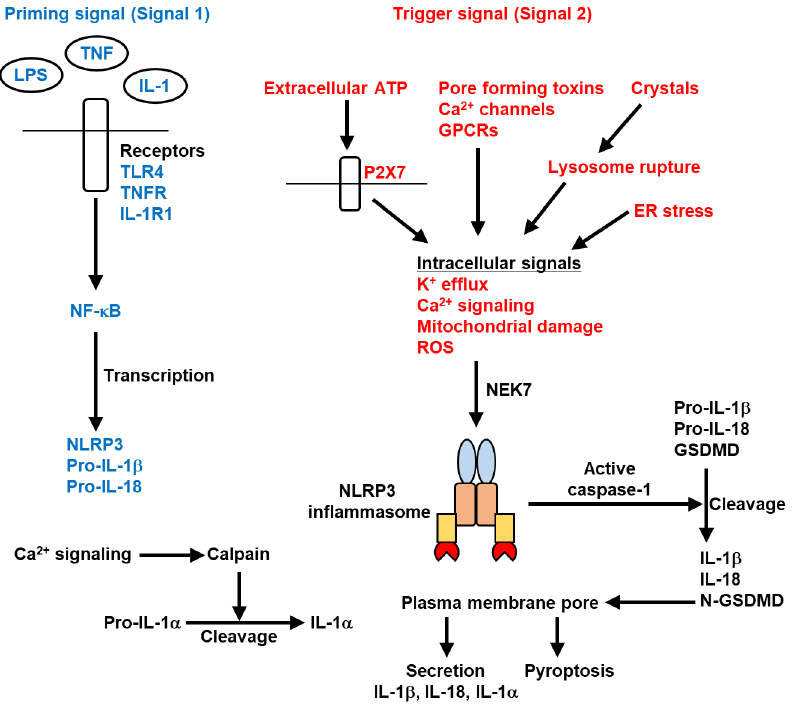
Figure 2. Mechanism of NLRP3 inflammasome activation. Pathogen-associated molecular patterns (PAMPs), such as lipopolysaccharide (LPS), or cytokines, such as TNF α and IL-1, induce a priming signal (Signal 1). The priming signal promotes expression of NLRP3, IL-1 β , and IL-18 through NF- κ B signaling. A trigger signal (Signal 2) is induced by specific PAMPs or damage-associated molecular patterns (DAMPs) such as bacterial infection, extracellular ATP, crystals, lysosomal rupture, mitochondrial damage, and endoplasmic reticulum (ER) stress, and leads to the assembly of NLRP3, ASC, and pro-caspase-1. Extracellular ATP stimulates P2X7 receptor. Phagocytosis of crystals induces lysosomal rupture. K + efflux, Ca 2+ signaling, mitochondrial damage, and reactive oxygen species (ROS) have been proposed to be the intracellular signals for NLRP3 inflammasome activation, while K + efflux is thought to be the most important signal. These intracellular signals are provided by at least the P2X7 receptor, pore-forming toxins, Ca 2+ channels, lysosomal rupture, ER stress, and G protein-coupled receptors (GPCRs). NEK7 is an essential positive regulator of the NLRP3 inflammasome and acts downstream of K + efflux. The NLRP3 inflammasome activates caspase-1, inducing IL-1β and IL-18 maturation and GSDMD cleavage. Pro-IL-1α is cleaved by Ca 2+ -dependent protease calpain and becomes mature IL-1α. N-terminal fragments of GSDMD (N-GSDMD) insert into the plasma membrane and form pores, leading to pyroptosis and secretion of IL-1β, IL-18, and IL-1α. Blue and red words indicate Signal 1 and Signal 2, respectively.